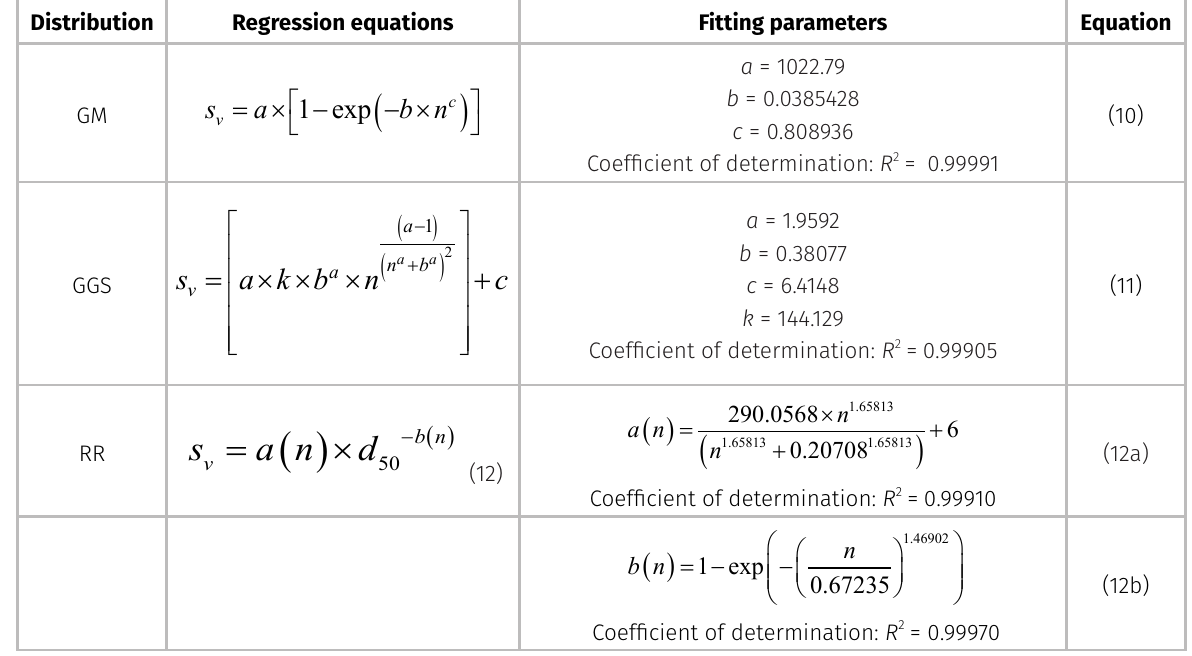
Table III. Equations and parameters from nonlinear regression. Distribution Regression equations Fitting parameters Equation